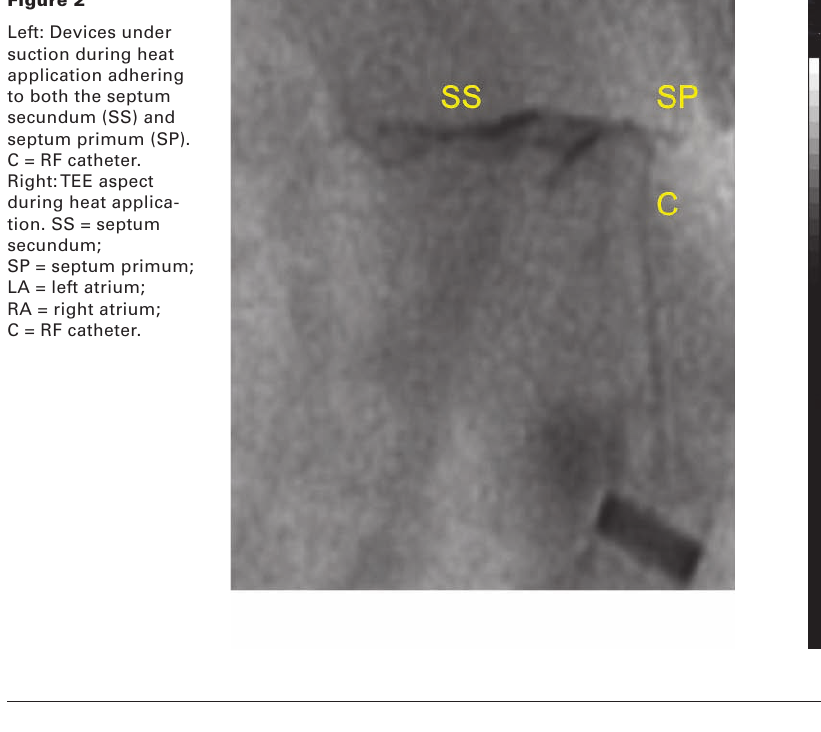
Figure 3 PFO diameters before (pre) the intervention and at 6 months (Fu).